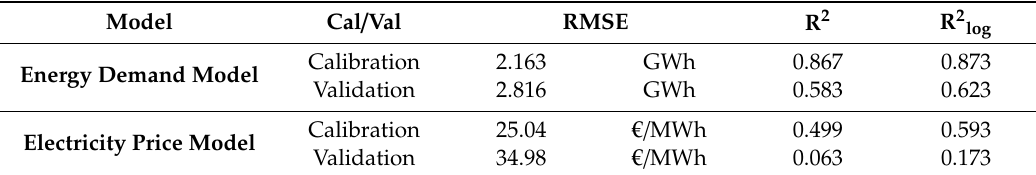
Table 1. Adaptation scores for calibration and validation of the Electricity Price Model and Energy Demand